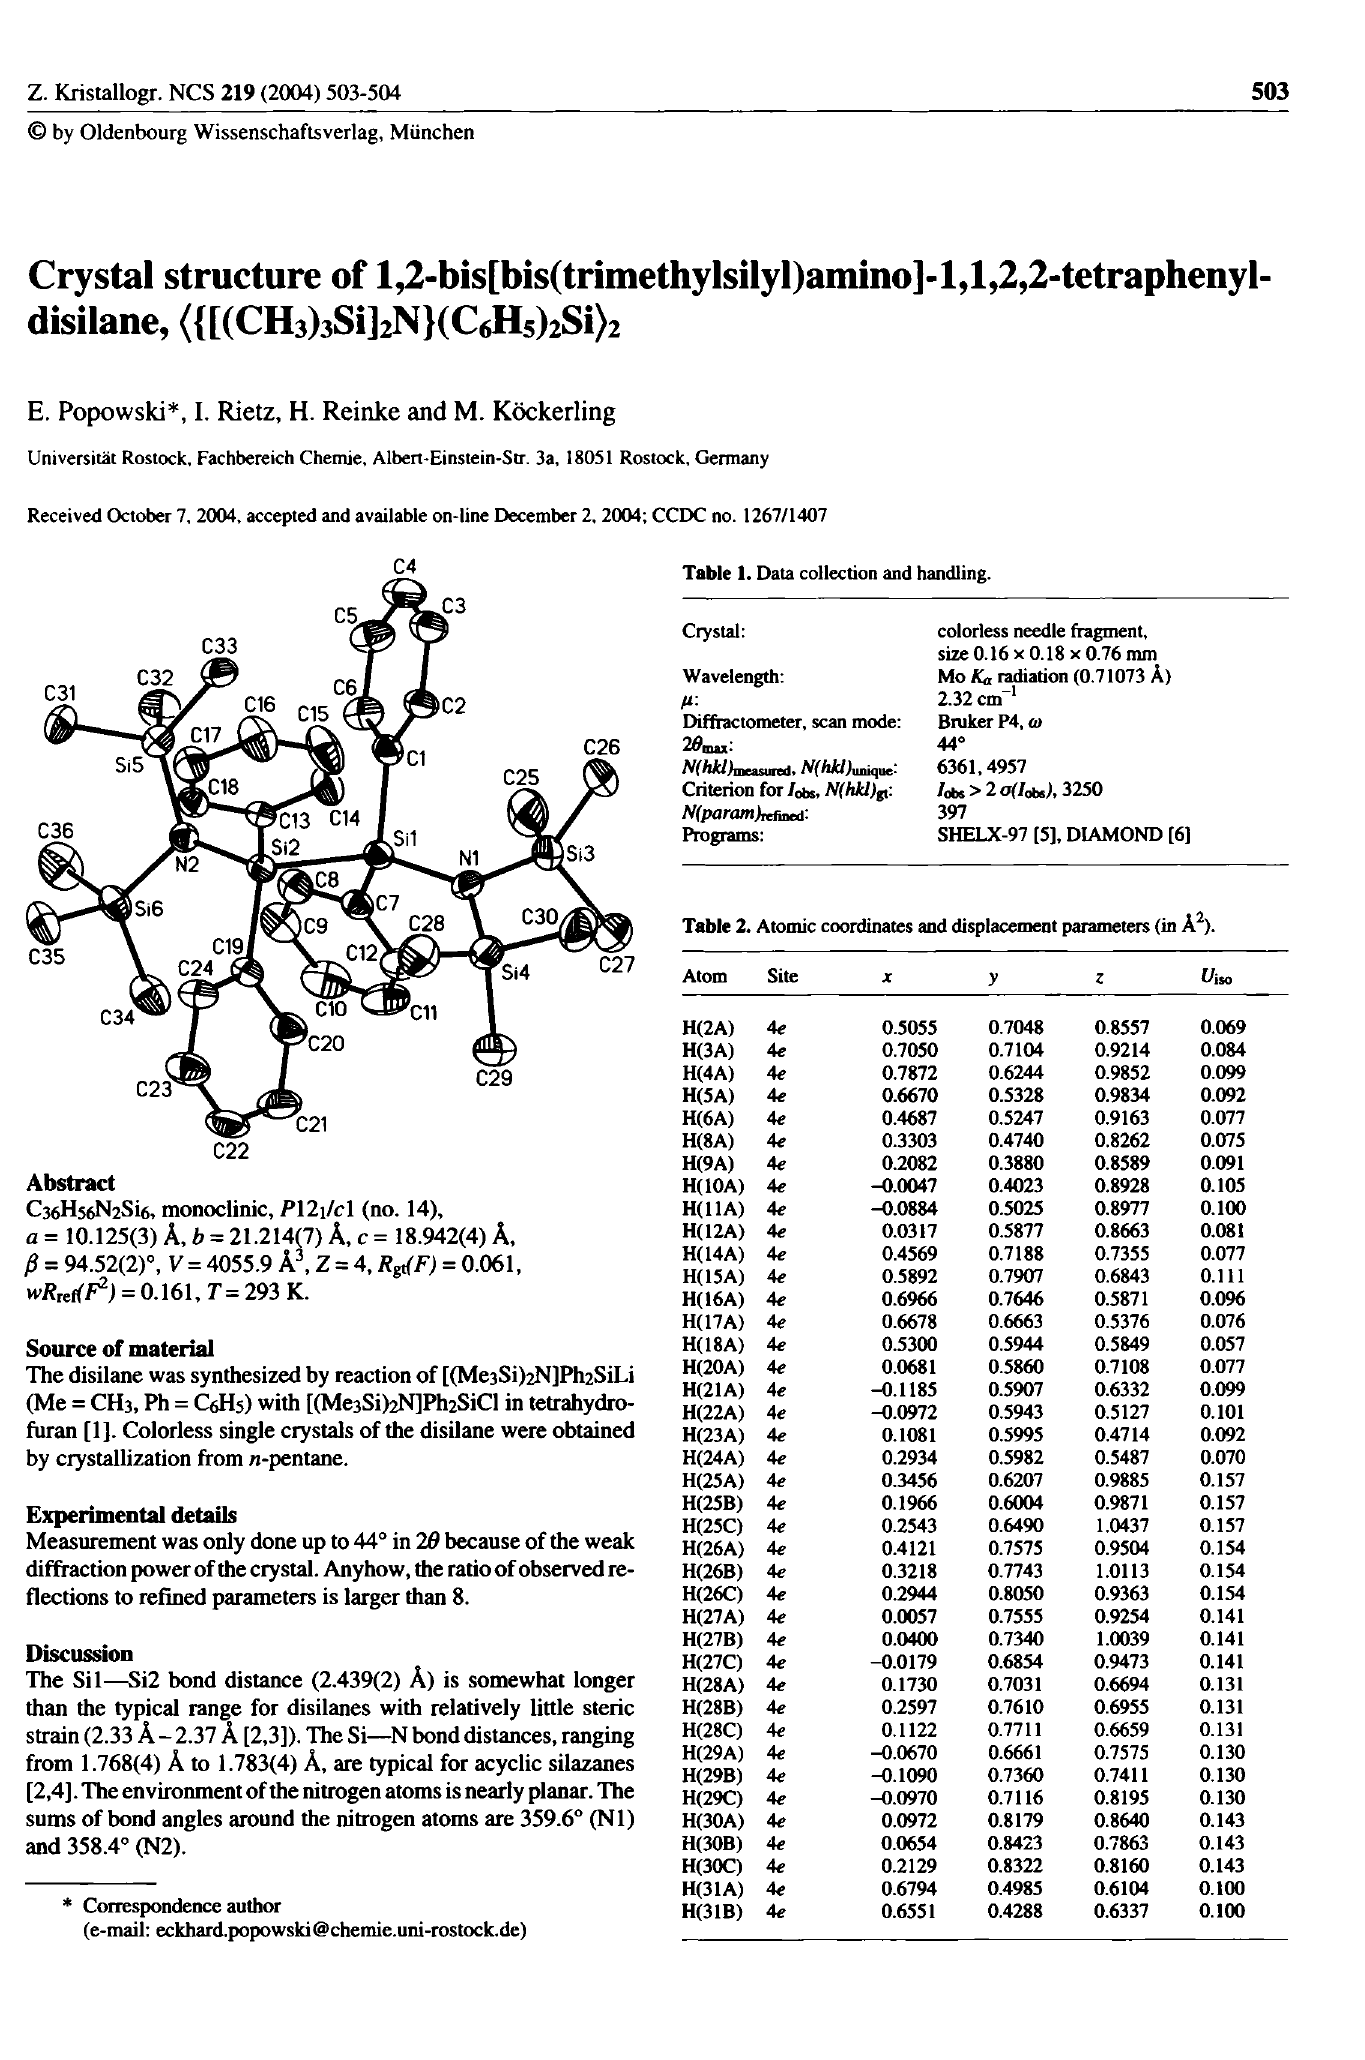
Table 1. Data collection and handling.